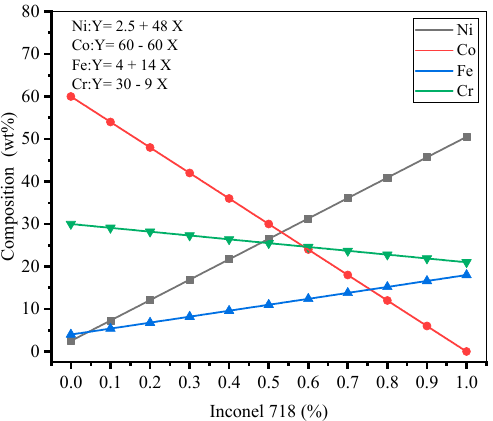
Figure 6. Design of Stellite-6/Inconel 718 FGM element distribution.